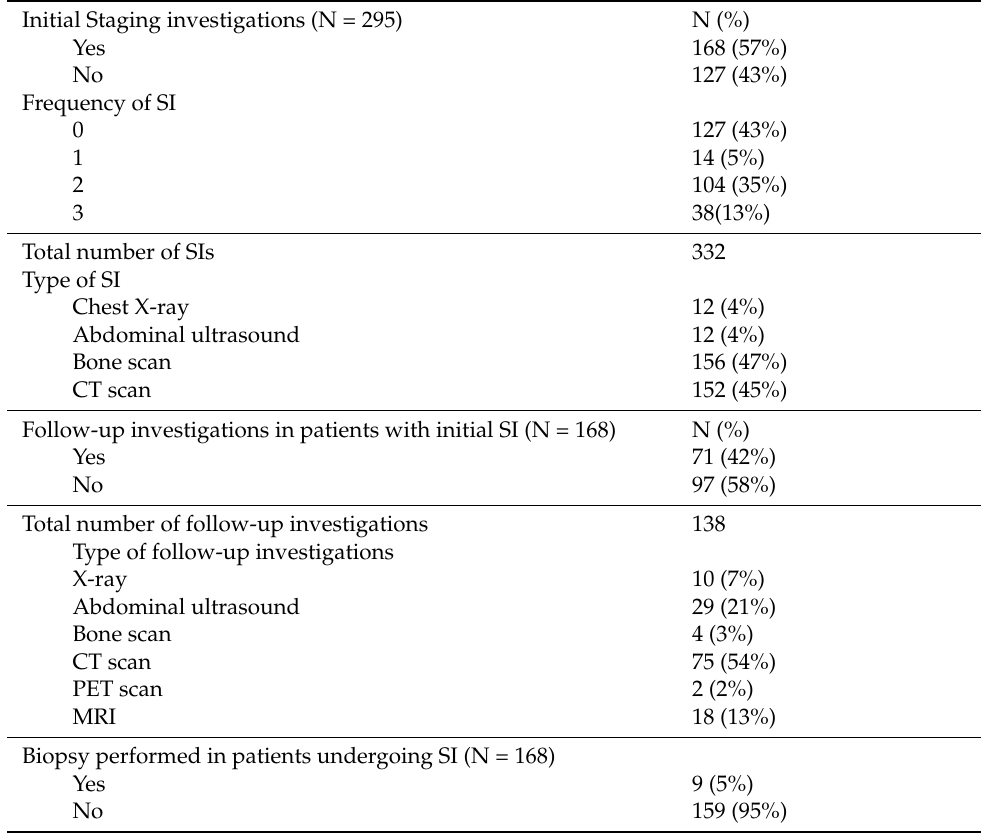
Table 2. Type and number of baseline and follow-up investigations (n = 295).